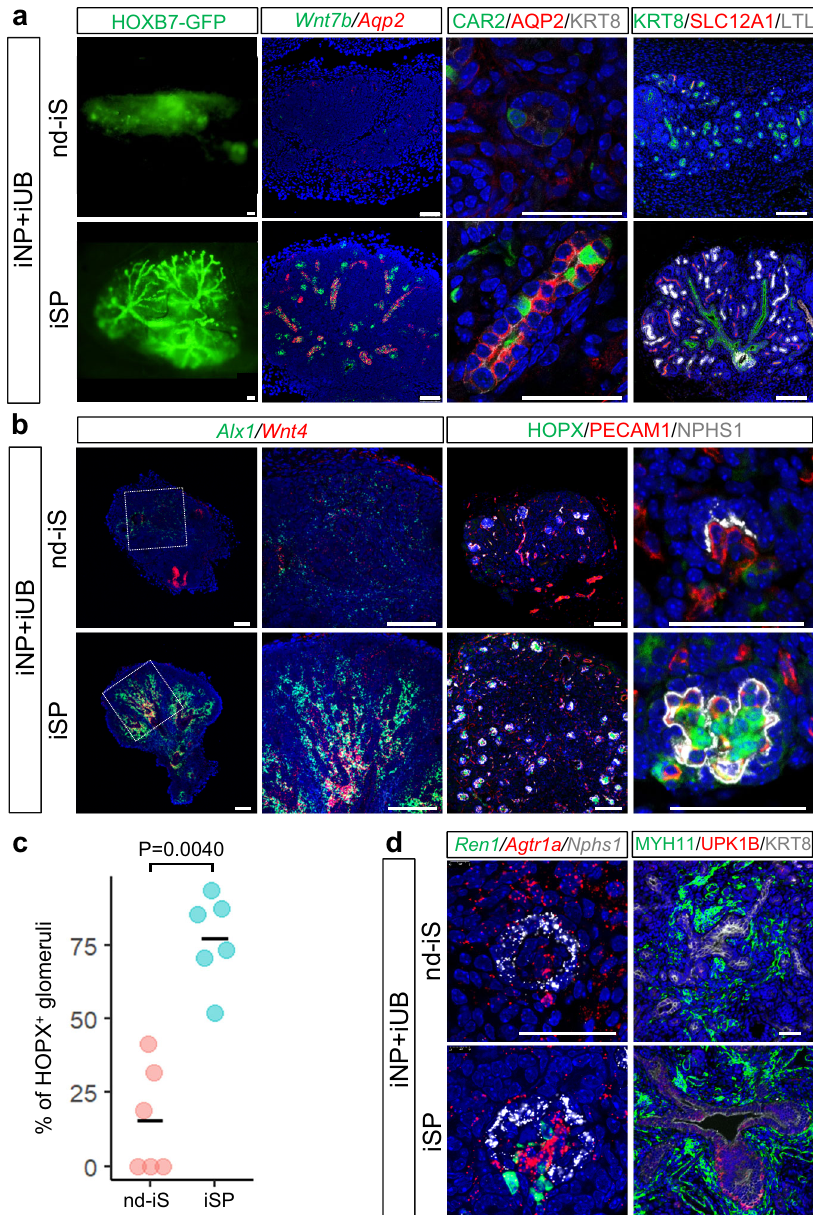
Fig. 5 Multiple types of interstitial cells are differentiated in the ESC-derived kidney upon transplantation. a Differentiation of UBs and nephrons in mouse ESC-derived transplanted organoids (generated using iSPs or nd-iS). 1st column: GFP images of UBs; 2nd column: in situ hybridization of Wnt7b (UB stalks) and Aqp2 (principal cells); 3rd column: immunostaining of CAR2 (intercalated cells), AQP2 (principal cells), and KRT8 (UBs); 4th column: immunostaining of KRT8 (UBs), SLC12A1 (loops of Henle), and LTL (proximal tubules). Scale bars: columns 1 – 3, 50 µ m; column 4, 100 µ m. Six organoids in each condition obtained from three independent experiments were analyzed. b Differentiation of stromal cells. 1st column: in situ hybridization of Alx1 (medullary stroma) and Wnt4 (innermost medullar stroma); 2nd column: magni fi ed images of the fi rst columns; 3rd column: immunostaining of HOPX (mesangial cells), PECAM1 (ECs), and NPHS1 (glomerular podocytes); 4th column: magni fi ed images of the 3rd columns. Scale bars: 100 μ m. c Percentages of glomeruli equipped with HOPX + mesangial cells. Data are shown as mean ± SEM. Six organoids in each condition obtained from three independent transplantation experiments were analyzed. All organoids were serially sectioned, and two sections per organoid were stained to calculate the percentages of HOPX + mesangial cells. The non-parametric Mann – Whitney U test (two-sided) was performed. The source data are provided as a Source Data fi le. d Differentiation of mesangial cells and ureteric stroma. 1st column: in situ hybridization of Ren1 (renin cells), Agtra1 (mesangial cells), and Nphs1 (podocytes); 2nd column: staining of MYH11 (ureteric stroma), UPK1B (ureter epithelium), and KRT8 (UBs). Scale bars: 50 μ m. All of the data were obtained at day 14 post-transplantation, except for the GFP images of UBs obtained at day 10 post-transplantation. Six organoids in each condition obtained from three independent experiments were